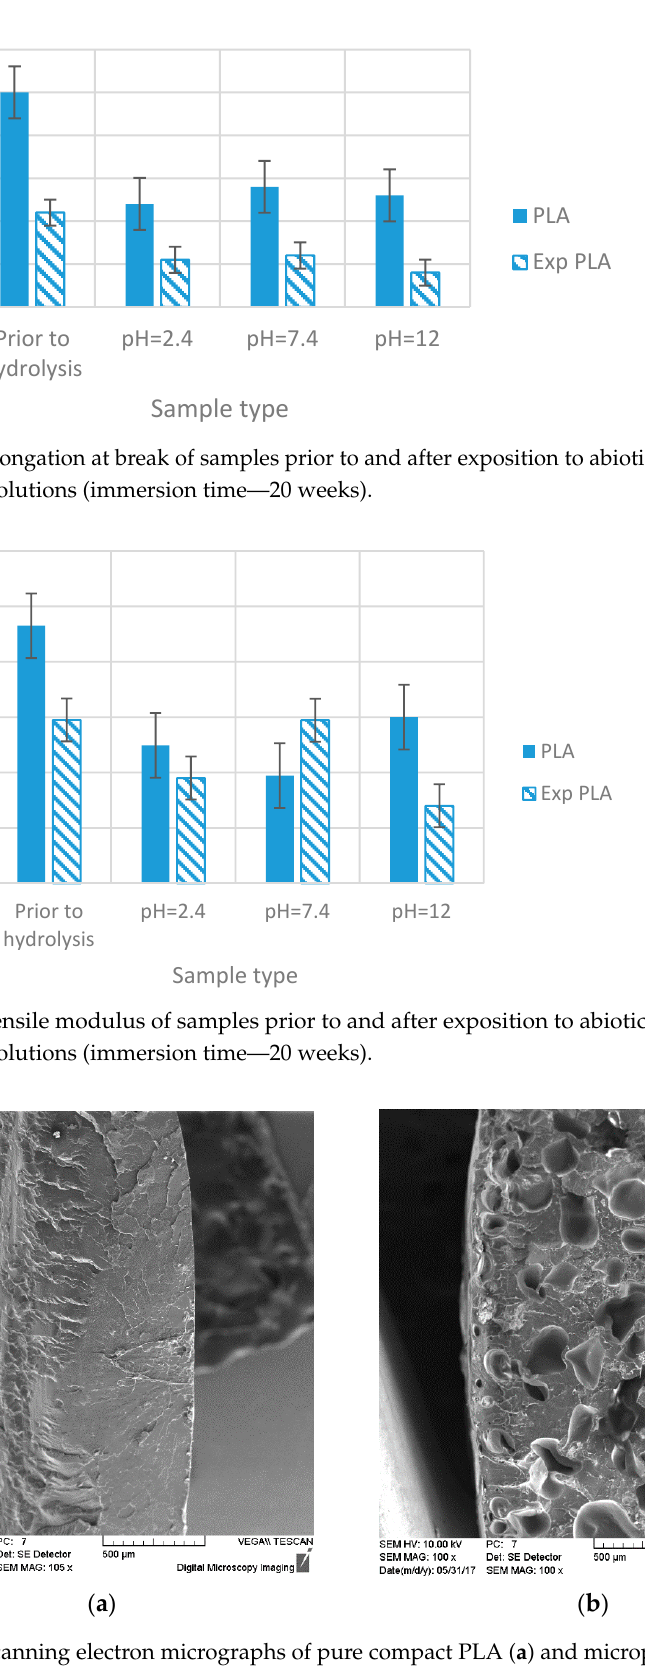
Figure 9. Scanning electron micrographs of pure compact PLA ( a ) and microporous PLA ( b ).